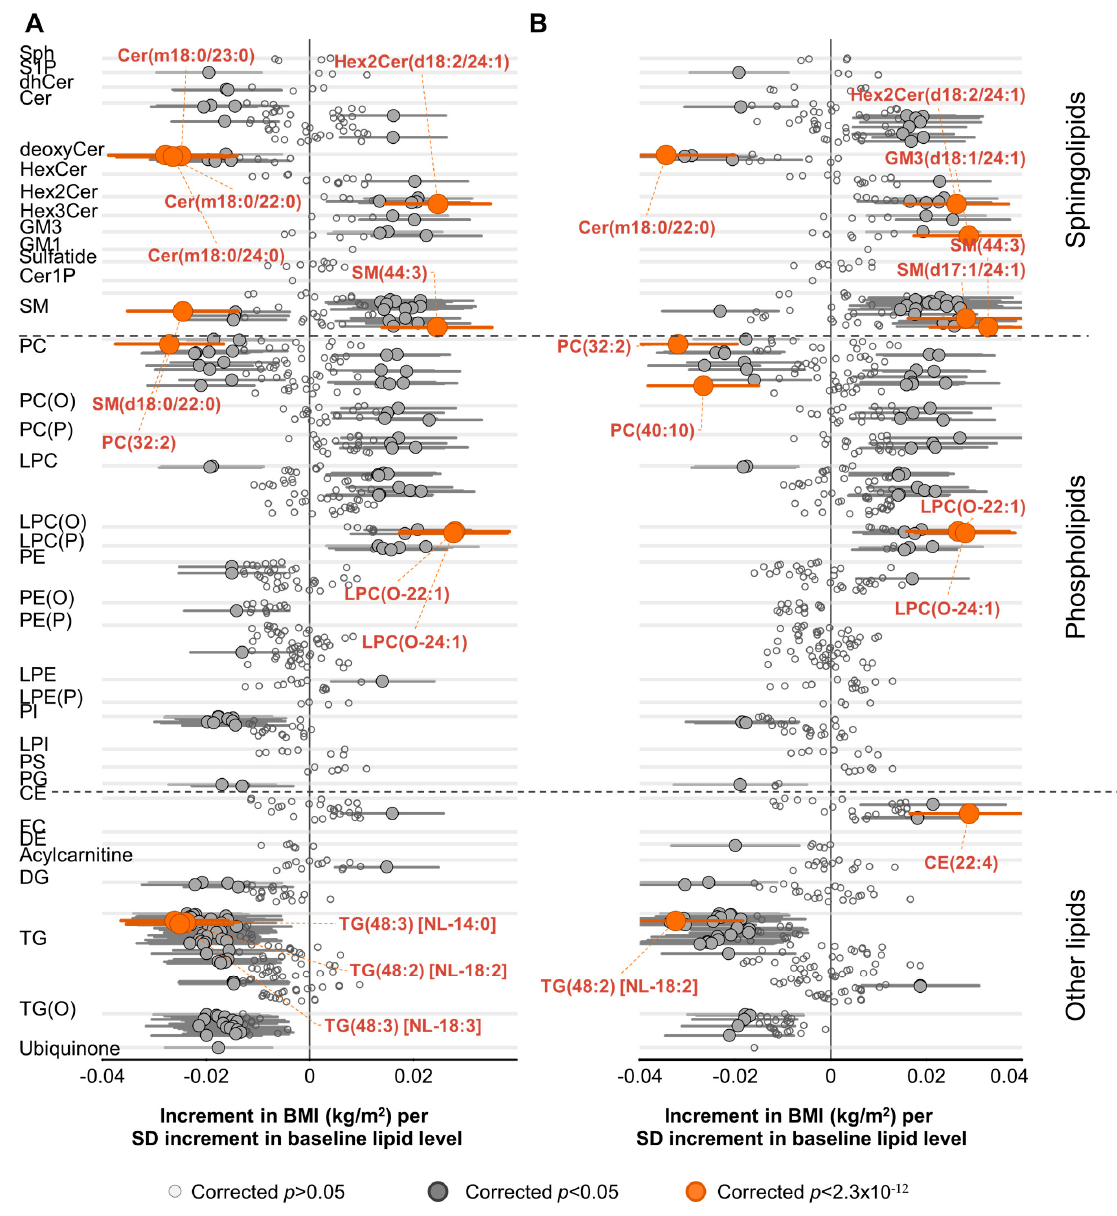
Figure 2. Association of lipid species with change in BMI. Linear regression analyses of SD normalized lipid species against annualized change in BMI were performed adjusting for ( A ) baseline age, sex and baseline BMI or ( B ) for baseline age, sex, baseline BMI, total cholesterol, HDL-C, triglycerides, education, smoking status, exercise time and television viewing time (panel B). The β -coefficients (95% CIs) represent the change in BMI per year associated with a SD difference of the lipid species level at baseline. Open circles show lipid species with corrected p > 0.05, closed circles show corrected p < 0.05 and orange circles show lipid species with the lowest corrected p -values. Whiskers represent the 95% confidence intervals.